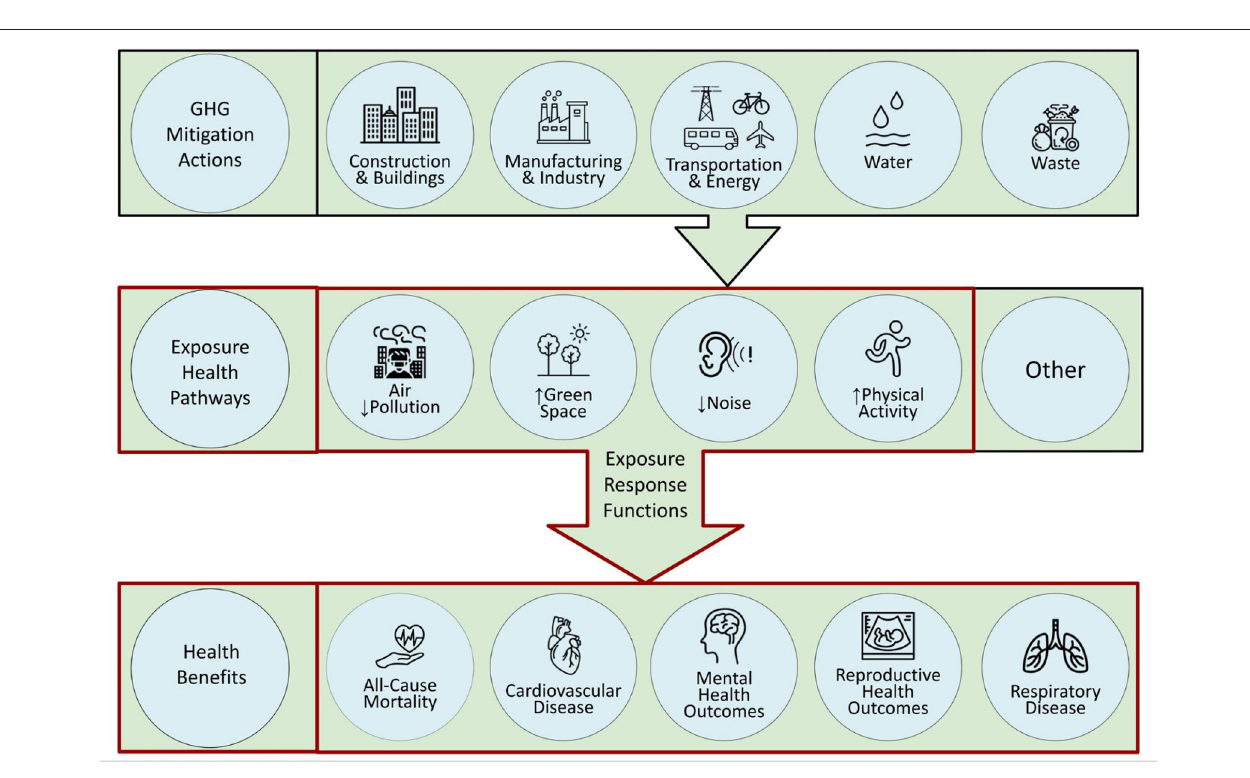
quantifying health benefits of urban climate actions across a range of relevant exposure–response pathways available to